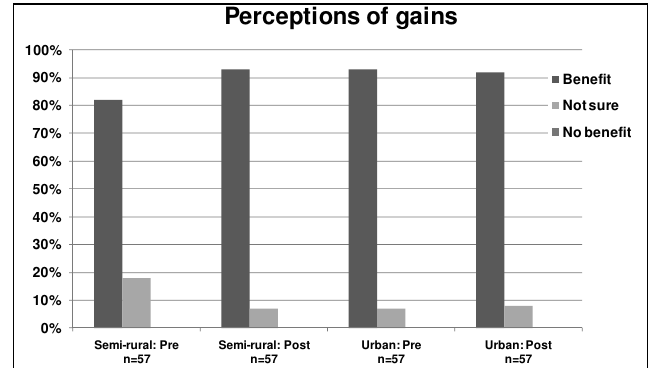
Fig. 3. Perceptions of knowledge and skill gains.